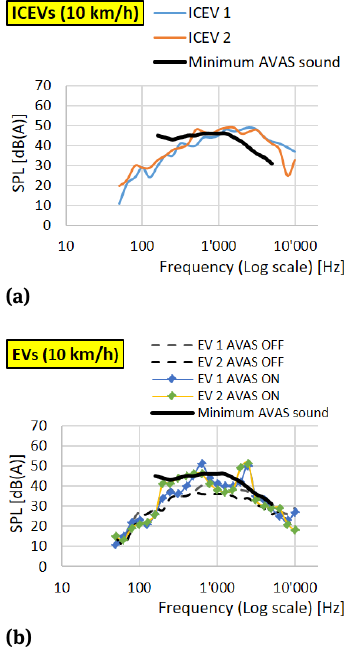
Figure 6: A-weighted Sound Pressure Level (ISO 362-1-1:2015) of AVAS sound vs. those of ICEVs and EVs (with AVAS on and off) mov- ing at 10 km/h based on the study [62] and the ECE regulation